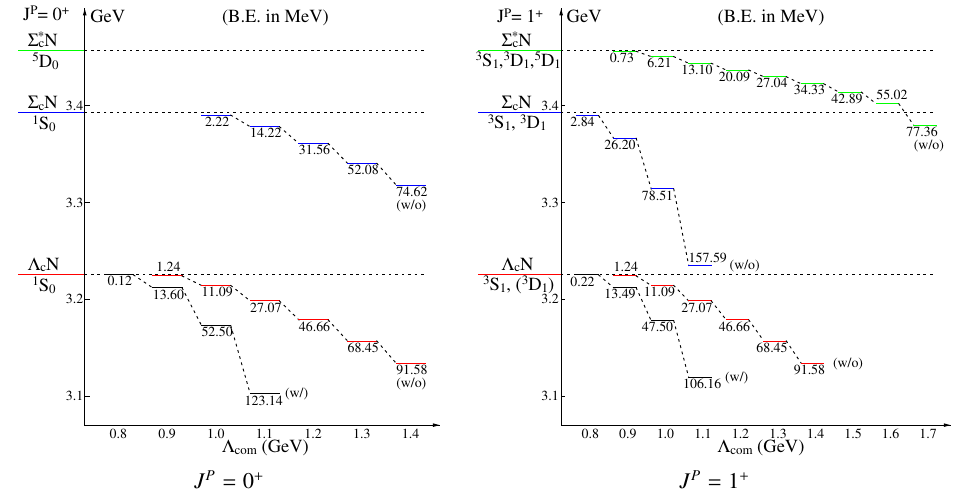
Fig. 3. The sensitivity of the binding energy (B.E.) to the cuto ff Λ π = Λ σ = Λ vec = Λ com in the OBEP model for the J P = 0 + and J P = 1 + cases. The cases without (w / o) and with (w / ) channel coupling are both shown. ( 3 D 1 ) means there is no S − D mixing when one considers only the Λ c N